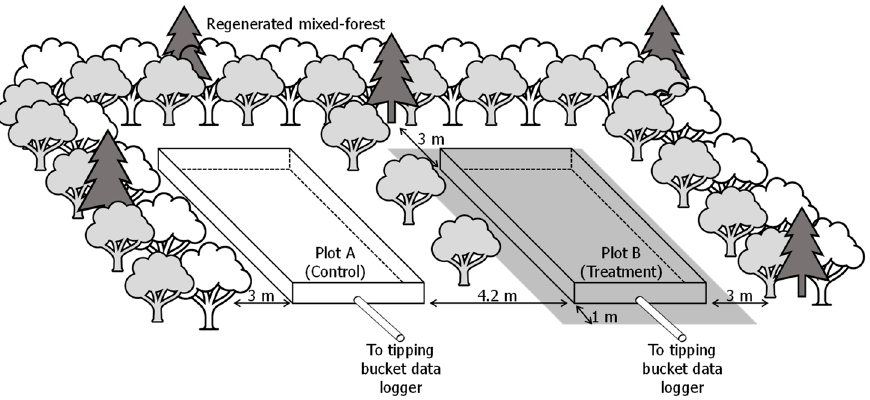
Figure 4. Experimental plots. Treatments were applied to the shaded area (larger than plot B). To ensure minimal disturbance to the soil surface, litter removal was carried out from outside the plot boundary and precautionary measures were taken to not step into the plot area. The dry weight of litter removed (including leaf, twigs, fruits, and seeds) was 9.48 kg (oven dried at 60 °C for 72 h). In the clearcutting phase, a total of 13 trees (species: Deutzia crenata , Eurya japonica , Gamblea innovans , Ilex pedunculosa , and Lyonia ovalifolia ) with DBH ranging 0.8–3.5 cm as well as 10 small shrubs were removed from plot B. In plot A (control plot), six trees (species: E. japonica and L. ovalifolia ) and small shrubs were left as they were. Although having fewer trees than in plot B, one of the trees ( E. japonica ) in plot A was multi-stemmed (nine stems), resulting in a canopy coverage that was more extensive than that of a normal tree. To minimise external environmental influence, areas adjacent to the plots were made to be as similar as possible to that inside the plots. Areas surrounding plot A (3 metres away from the top, left, and bottom boundary) were left forested. For plot B, a 1-metre buffer from the perimeter (plot boundary) was given the same treatment (litter removal and clearcutting) as inside the plot. Photographs of plot B in the NT, LRBC, and AC phases are shown in Figure 5.